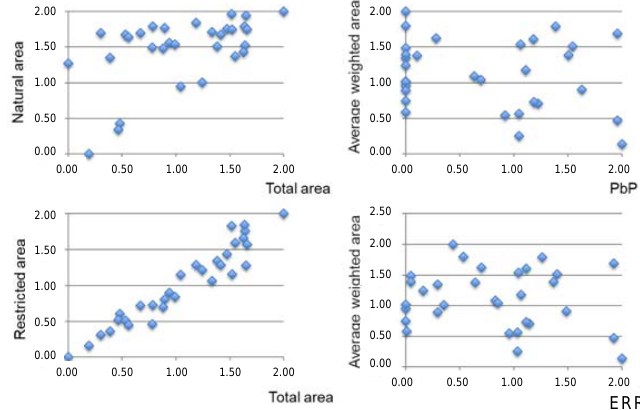
Figure 12. Complementarity and trade-offs between variables.